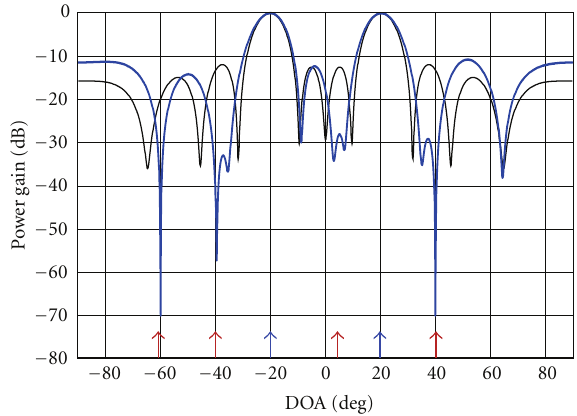
Figure 5: Adapted pattern of 10-element linear array with 3 desired signals (45 ◦ , 90 ◦ , 135 ◦ ).